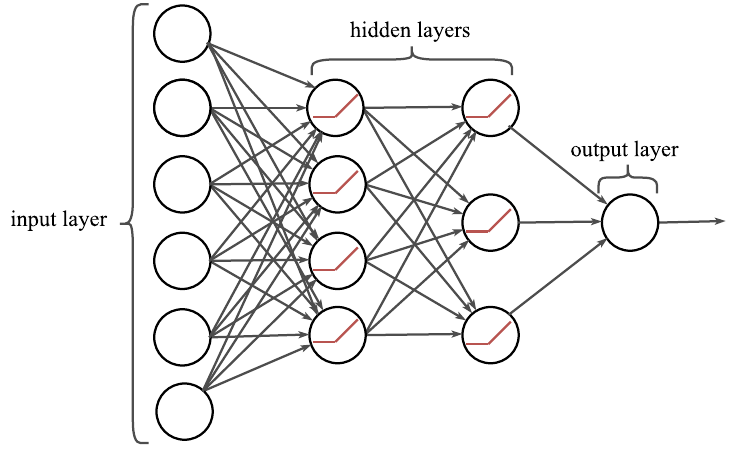
Figure 5. Illustration of the multilayer perceptron artificial neural network implementation for the power draw predictions. Each neuron uses a rectified linear unit (ReLU) as the activation function. The example network shows six inputs, two hidden layers, and one